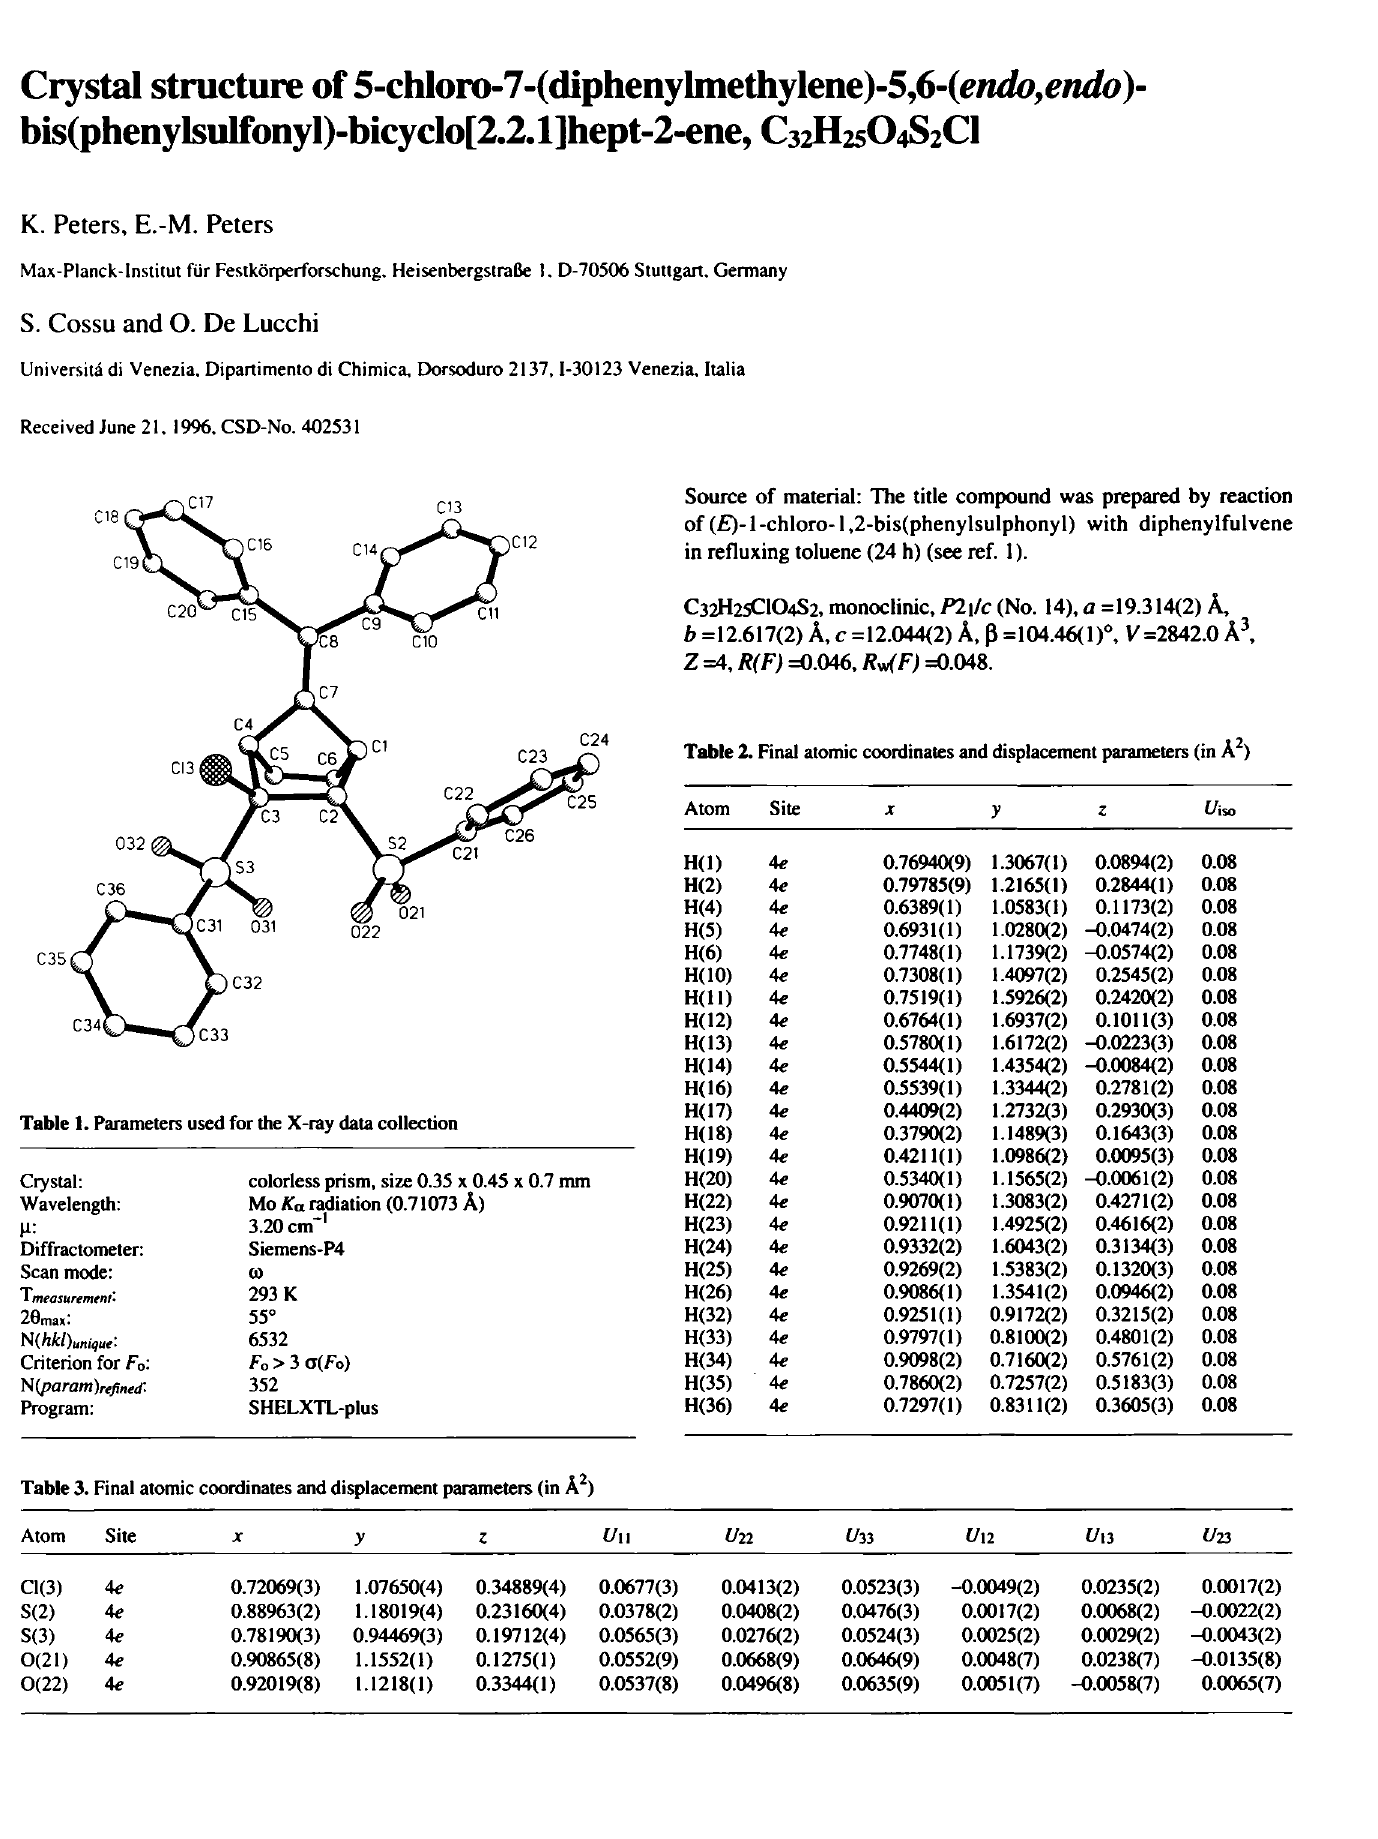
Source of material: The title compound was prepared by reaction